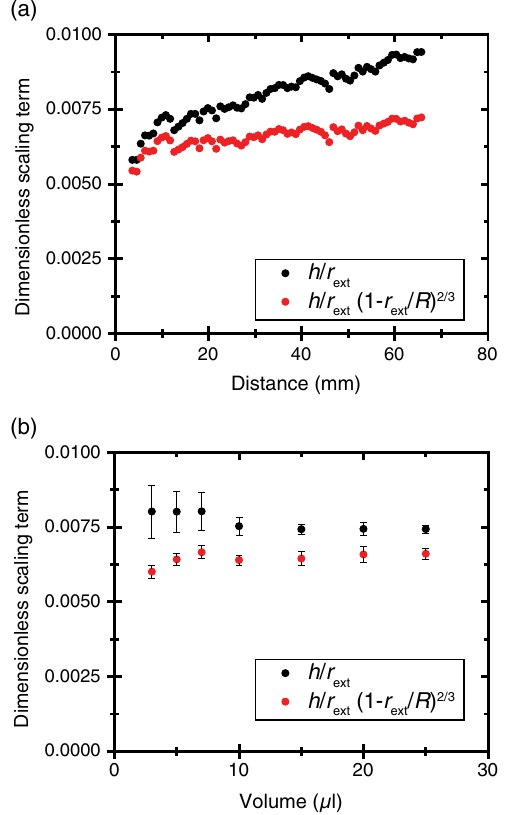
FIG. 10. (a) Comparison of the full and simplified scaling parameter for a 3 - μ l droplet moving at 300 μ m = s on a 20-cP ¼ 4 μ m, and (b) comparison silicone-oil-infused surface with h i of the averaged scaling parameter for droplets of different volumes under the same conditions as